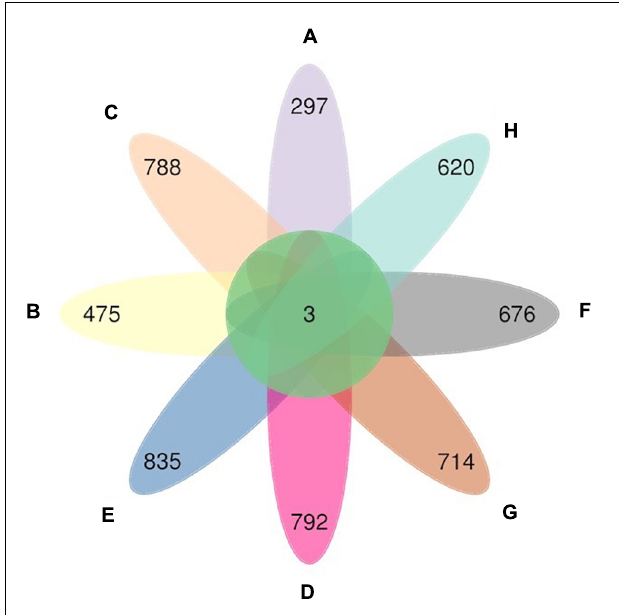
FIGURE 5 | Venny analysis of raw milk samples used in this study. A. Heilongjiang, B. Inner Mongolia, C. Gansu, D. Henan, E. Anhui, F. Jiangsu, G. Chongqing, and H.